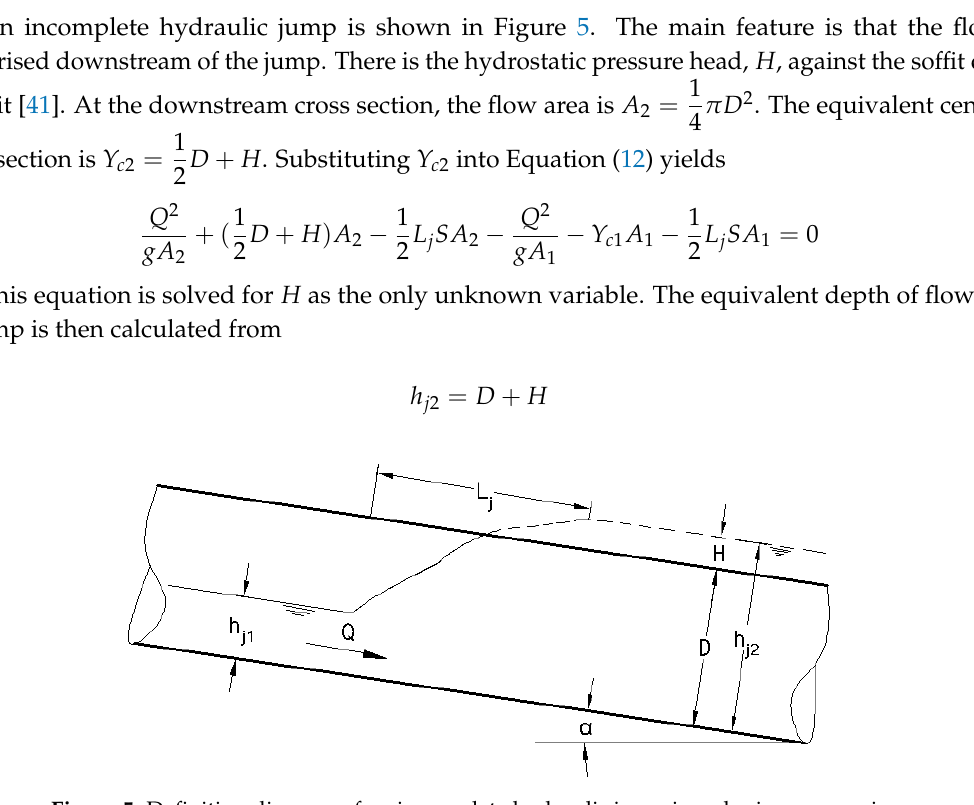
Figure 5. Definition diagram of an incomplete hydraulic jump in a sloping sewer